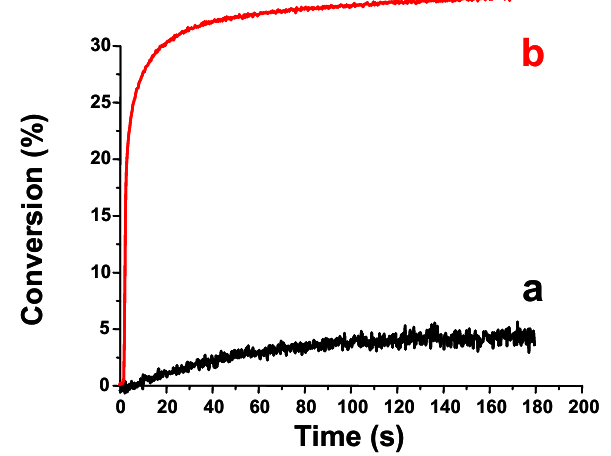
Figure 2. Polymerization profiles of trimethylolpropane triacrylate. Photoinitiated system: (a) diphenyl (2,4,6-trimethylbenzoyl)-phosphine oxide (1% w/w) and (b) diphenyl (2,4,6- SiH (1%/2% w/w) under trimethylbenzoyl)-phosphine oxide/(TMS) 3